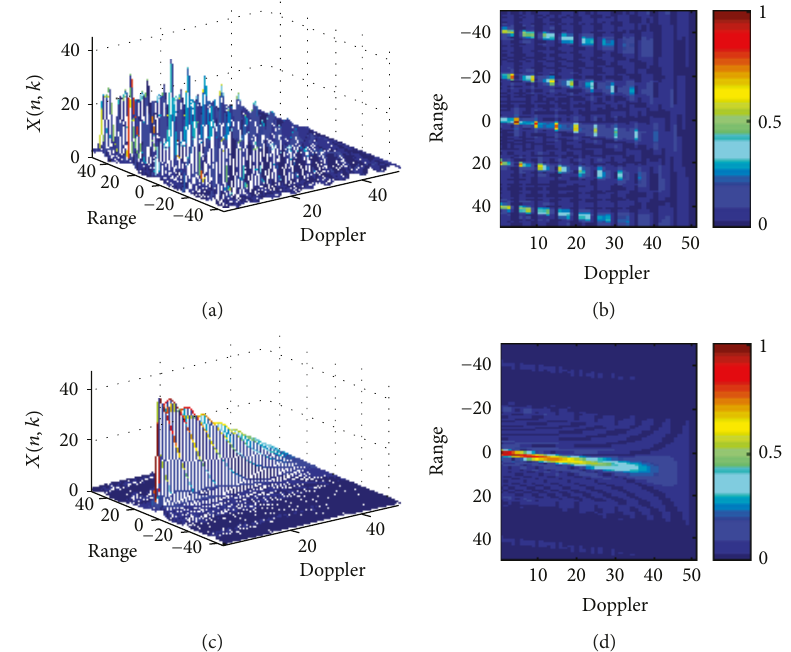
Figure 3: Ambiguity function ( N = 50 ). (a, b) The fi rst K phases of the frequency are random; (c, d) the fi rst K phases of the frequency are equal